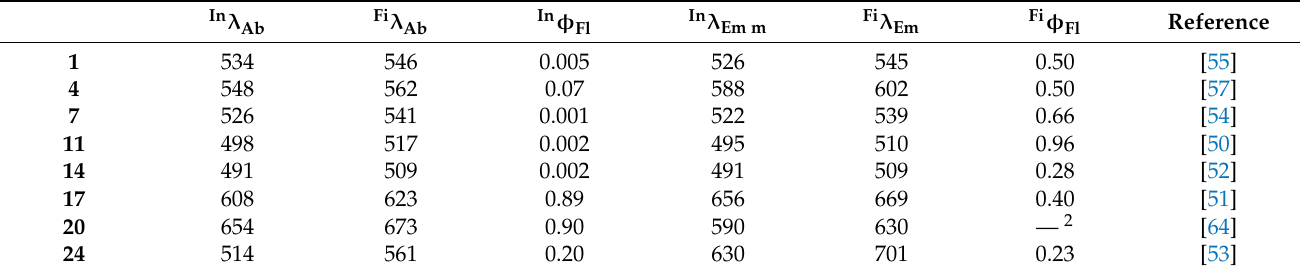
Figure 6. Absorption ( a ) and emission ( b , λ Ex = 470 nm) spectra (black traces) of an equimolar MeCN solution of 1 and Bu 4 NOH (10 µ M) at 25 ◦ C. Emission spectra ( λ Ex = 470 nm, green traces) of the same solution after irradiation ( λ Ac = 300–410 nm, 3.33 mW cm ™2 ) for 5 ( c ), 10 ( d ), 15 ( e ), 20 ( f ) and 25 min ( g ). Table 1. Photophysical parameters. 1